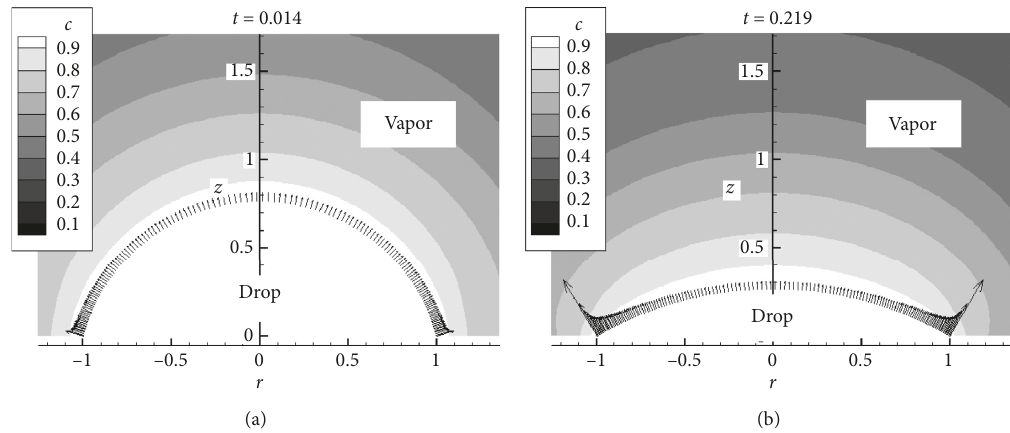
Figure 4: Evaporation flux distribution along the droplet surface, initial AR � 0.8, Ca � 8.41 × 10 − 8 .